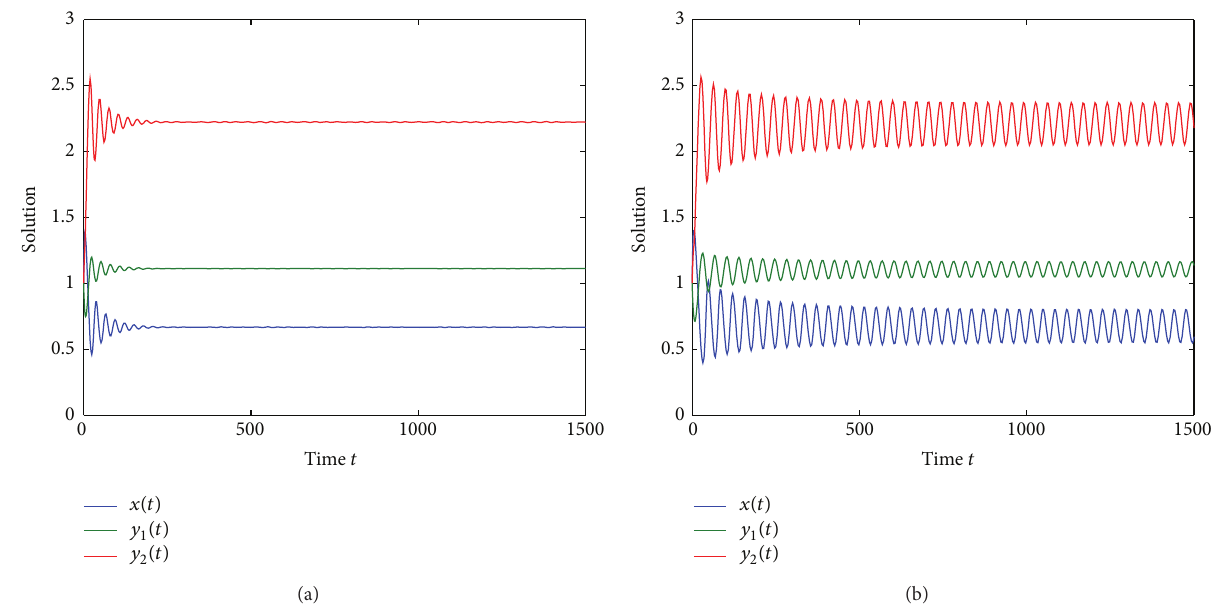
Figure 1: The numerical solution of system (3) with 𝑎 = 0.5 , 𝑎 1 = 0.4 , 𝑎 2 = 0.4 , 𝑒 = 0.1 , 𝐷 = 0.1 , 𝑟 = 1 , 𝑟 1 = 0.1 , 𝑟 2 = 0.25 , 𝑚 = 0.5 ; (a) 𝜏 = 3